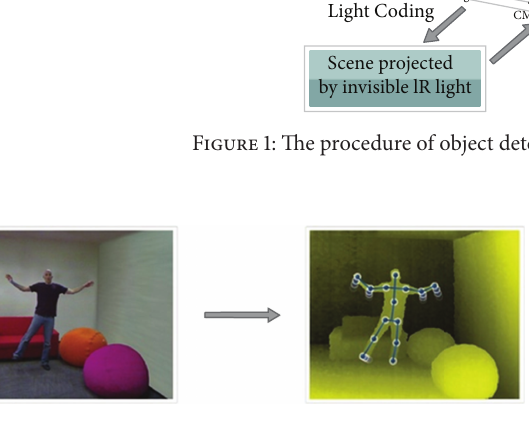
Figure 2: The skeleton of human body and tracking (PrimeSense).